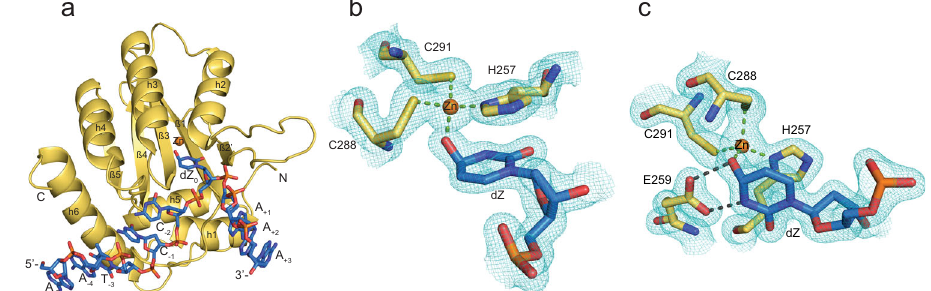
Fig.1|StructureofactiveAPOBEC3Gcatalyticdomain(A3G-CTD2)withssDNA containing 2 ′ -deoxy-zebularine at the target site. a The asymmetric unit con- tains one protein shown as cartoon (yellow) and one oligonucleotide inhibitor (blue) shown assticks. N and C indicate the N- and C-terminalends of the protein, 5 ′ - and 3 ′ - indicates 5 ′ and 3 ′ ends of the oligonucleotide. b A 2Fo – Fc electron density map contoured at 1.5 σ is shown in cyan around the 2 ′ -deoxy-zebularine hydrated intermediate (dZ-H 2 O), the Zn 2+ ion, and the Zn 2+ coordinating residues. The 3 ′ -oxygenofthe preceding nucleotide of dZ- isnotshown. Zn 2+ is shownasan orange sphere. C, N, S and O atoms are colored yellow, navy blue, gold, and red respectively, for amino acid residues of the protein. Atoms in nucleotides are